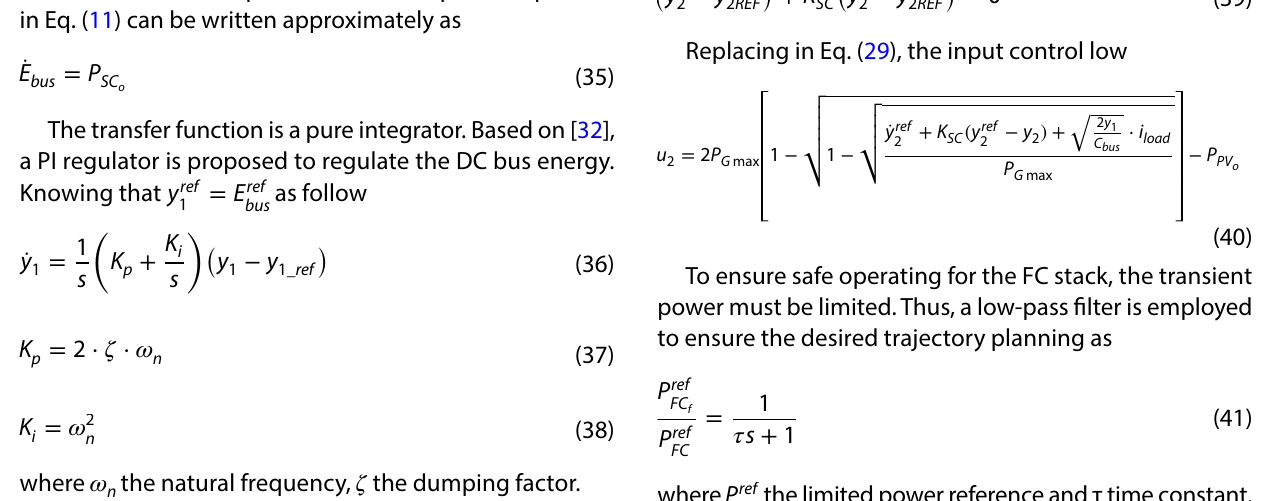
Figure 8 resume the control algorithm of the SC energy.